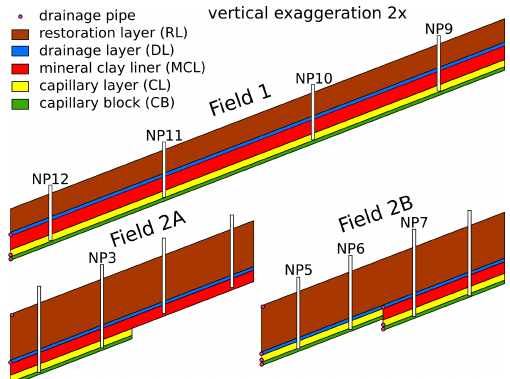
Figure 3. Cross sections of lysimeter Field 1 and Field 2 with the different layers and moisture measurement points.